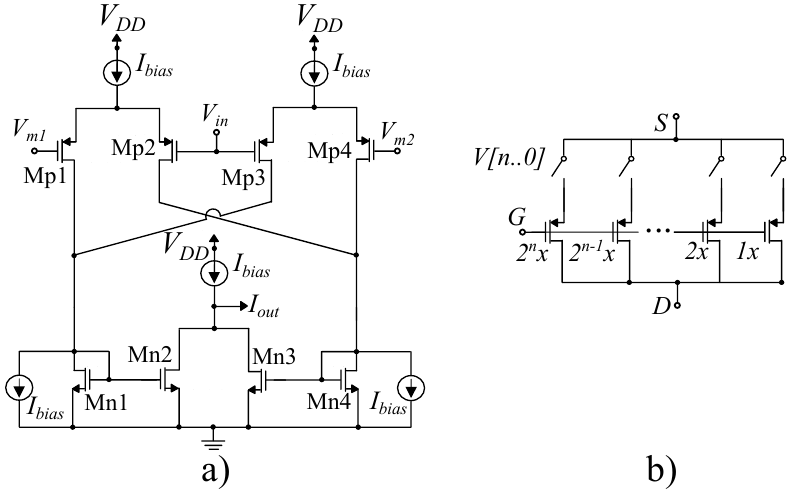
Figure 31. A Gaussian function circuit using a multiplexer to adjust the multiplicity of the transistors in the differential pairs. ( a ) schematic ( b ) block for selecting transistors with different dimensions via the